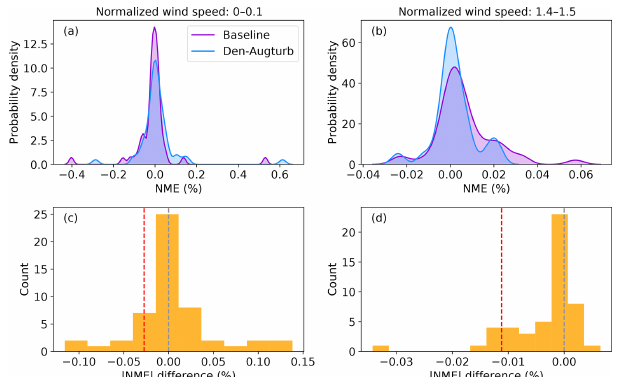
Figure 12. (a) Probability density distribution of NME per file count from the baseline method (purple) and the density and aug- mented turbulence (Den-Augturb) method (blue) for the outer range normalized wind speeds between 0 and 0.1; (b) as in (a) , but for the outer range normalized wind speeds between 1.4 and 1.5. (c) His- togram of the differences in absolute NMEs between the baseline and the Den-Augturb shown in (a) ; (d) as in (c) , but for the dif- ferences shown in (b) . The grey and red dashed lines denote the zero NME difference and the 10th percentile of NME differences, respectively. Note that the ranges of the panel axes